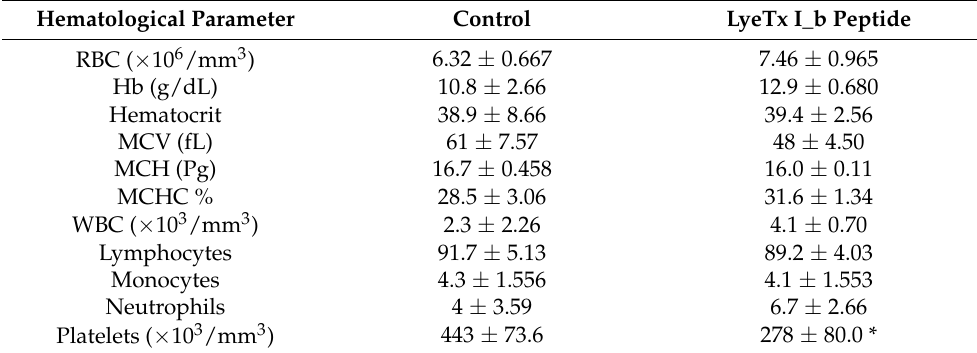
Table 2. Hematological values of healthy BALB/C animals after systemic administration of 5 mg/kg LyeTx I-b (7 doses/48 h